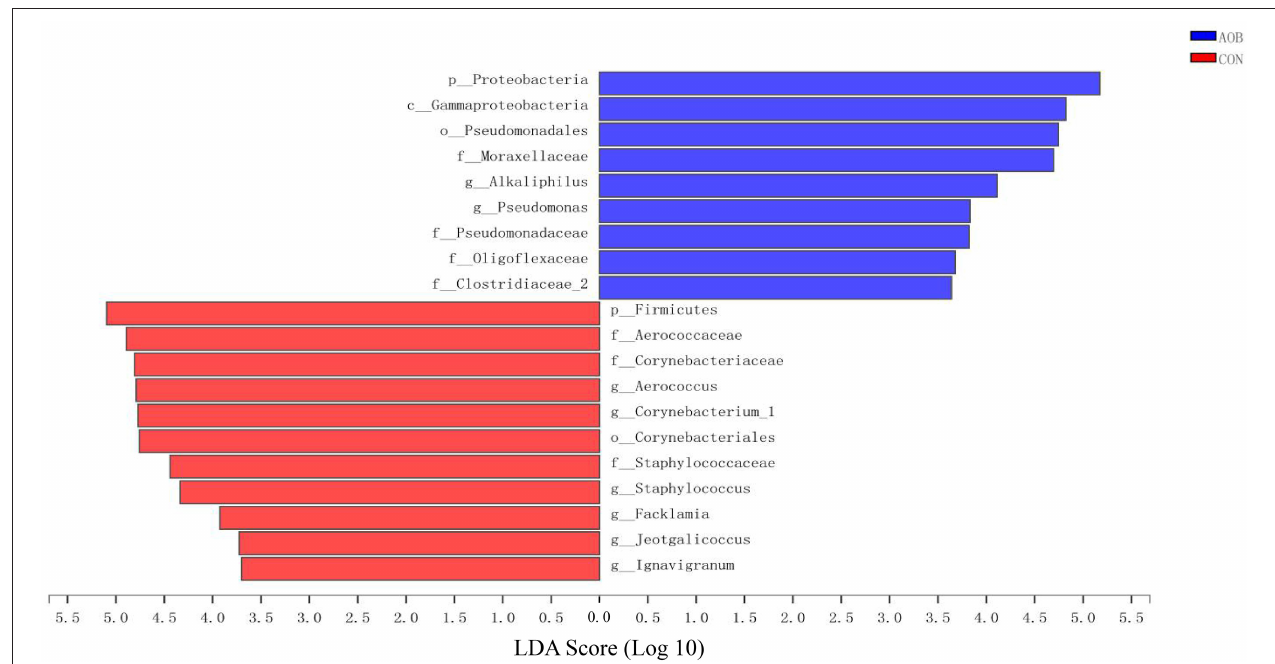
FIGURE 3 | The LEfSe analysis identified the most differential abundant taxa between the two groups. Linear discriminant analysis (LDA) scores for the bacterial taxa are differentially abundant between AOB and CON groups. Only the taxa having a p < 0.01 and LDA > 3.5 were shown. LEfSe: linear discrimination analysis together with effect